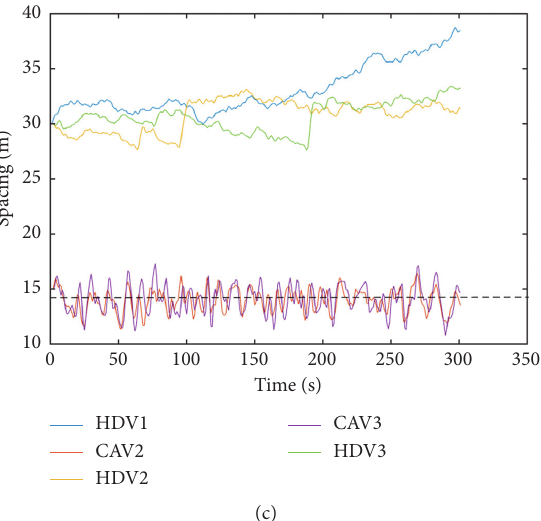
Figure 6: The fleet in dense fog environment with the visibility being 50m. (a) The location of formation. (b) The speed of formation. (c) The spacing of formation.